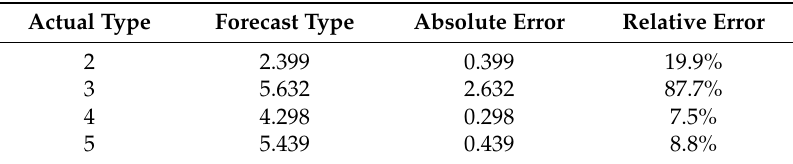
Table 7. PP regression forecast